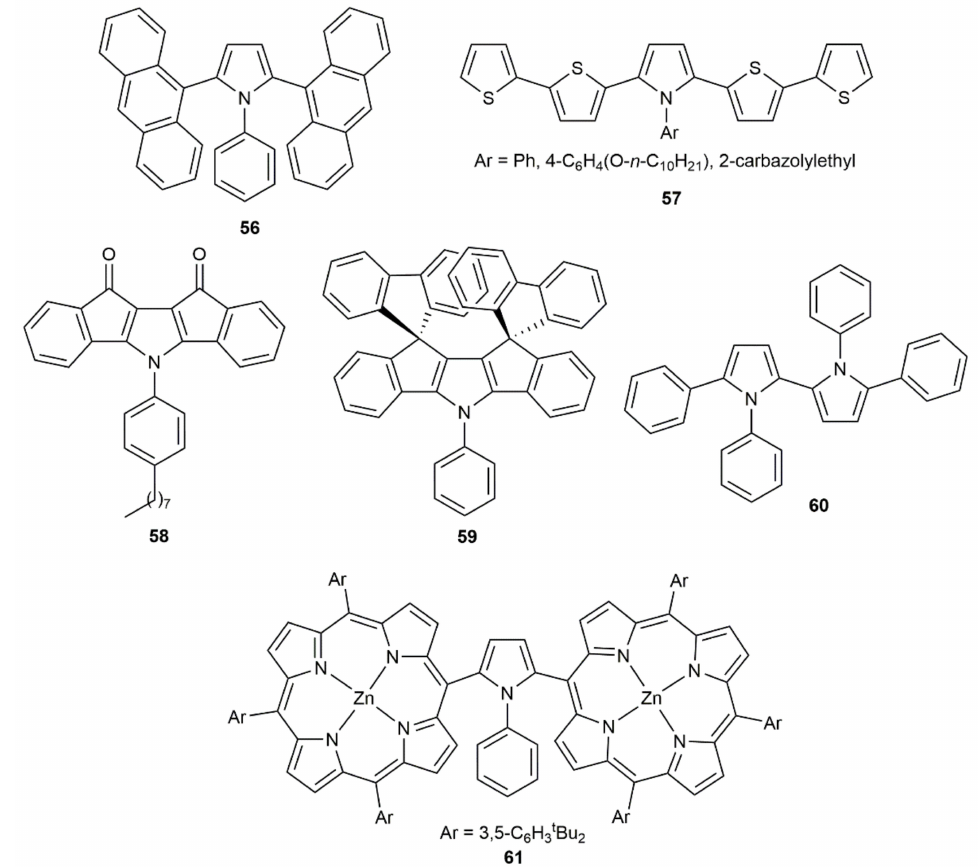
Figure 9. Structure of the elaborated pyrrole derivatives 56–61